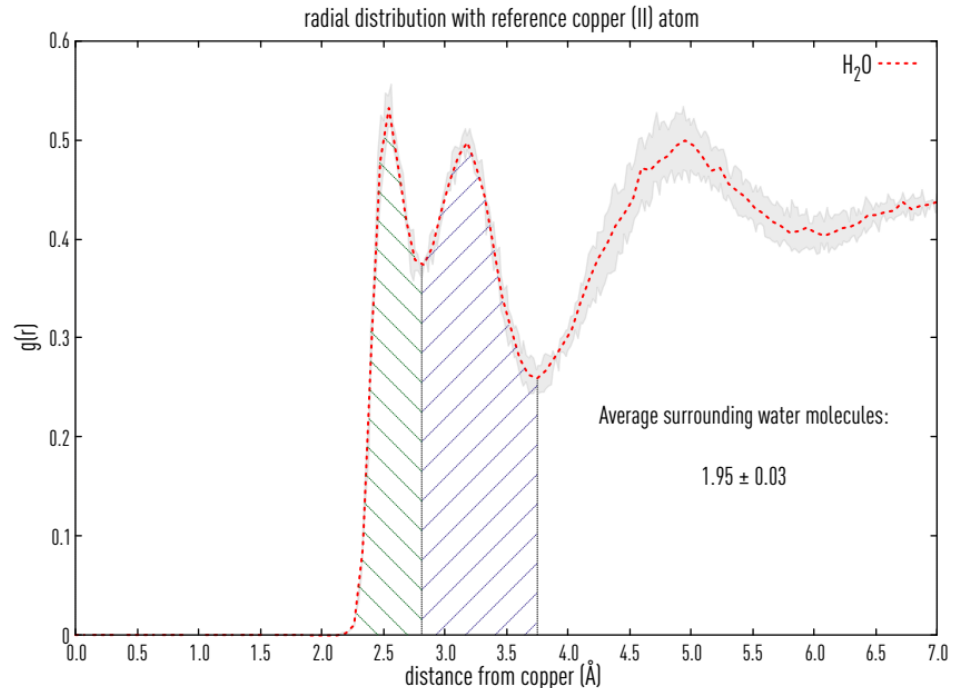
Figure 6. Radial distribution of water molecules with reference copper atom in the active site of Nc LPMO9C and the calculated water molecules surrounding the copper atom during 200 ns MD- Simulation. Calculation based on the integration of the marked area until the second minimum. Green and blue dashed areas represent first and second hydration shells of the copper atom. Data are mean values ( ± SD) of 3 independent